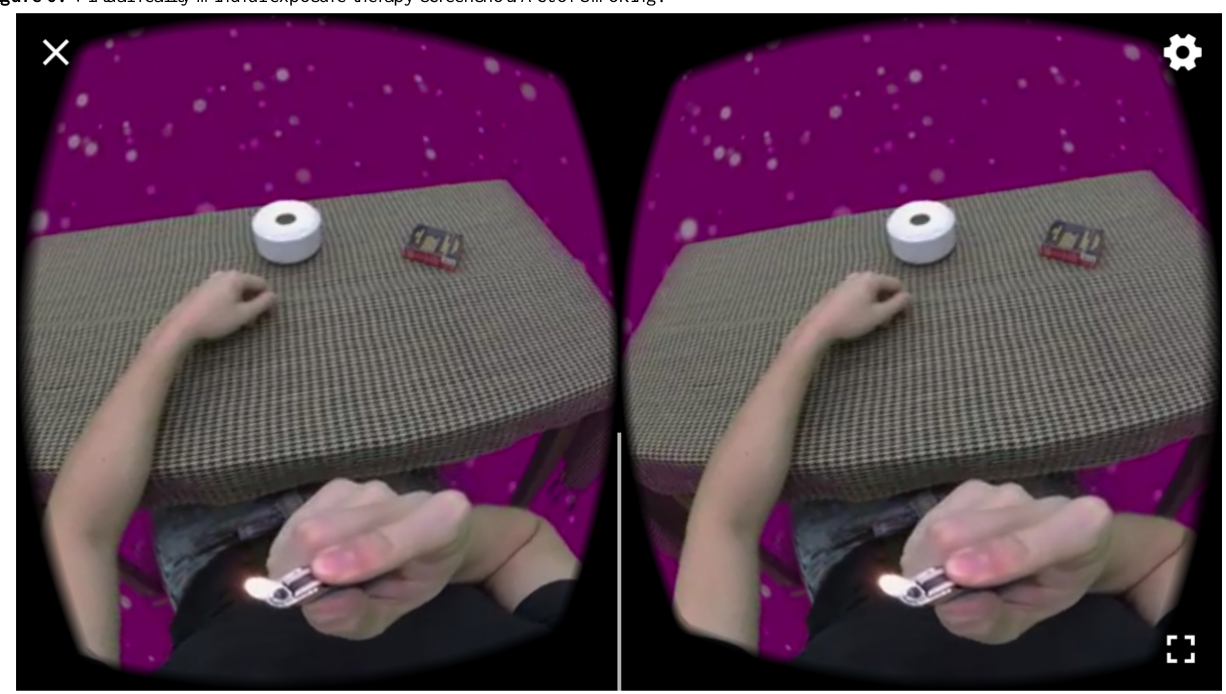
Figure 6. Virtual reality mindful exposure therapy screenshot: Act of